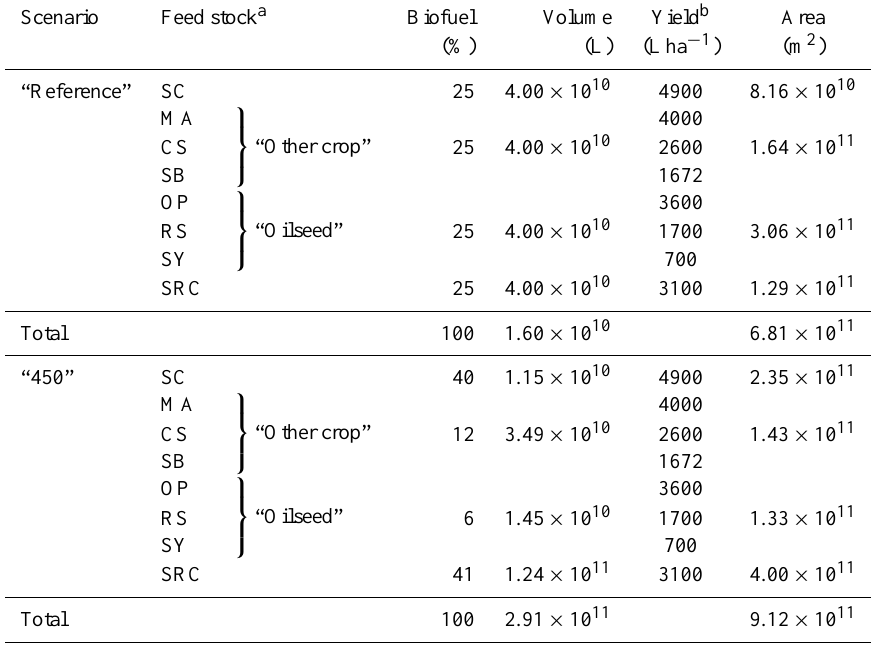
Table 2. Estimated total area required for biofuel production in the Reference and 450